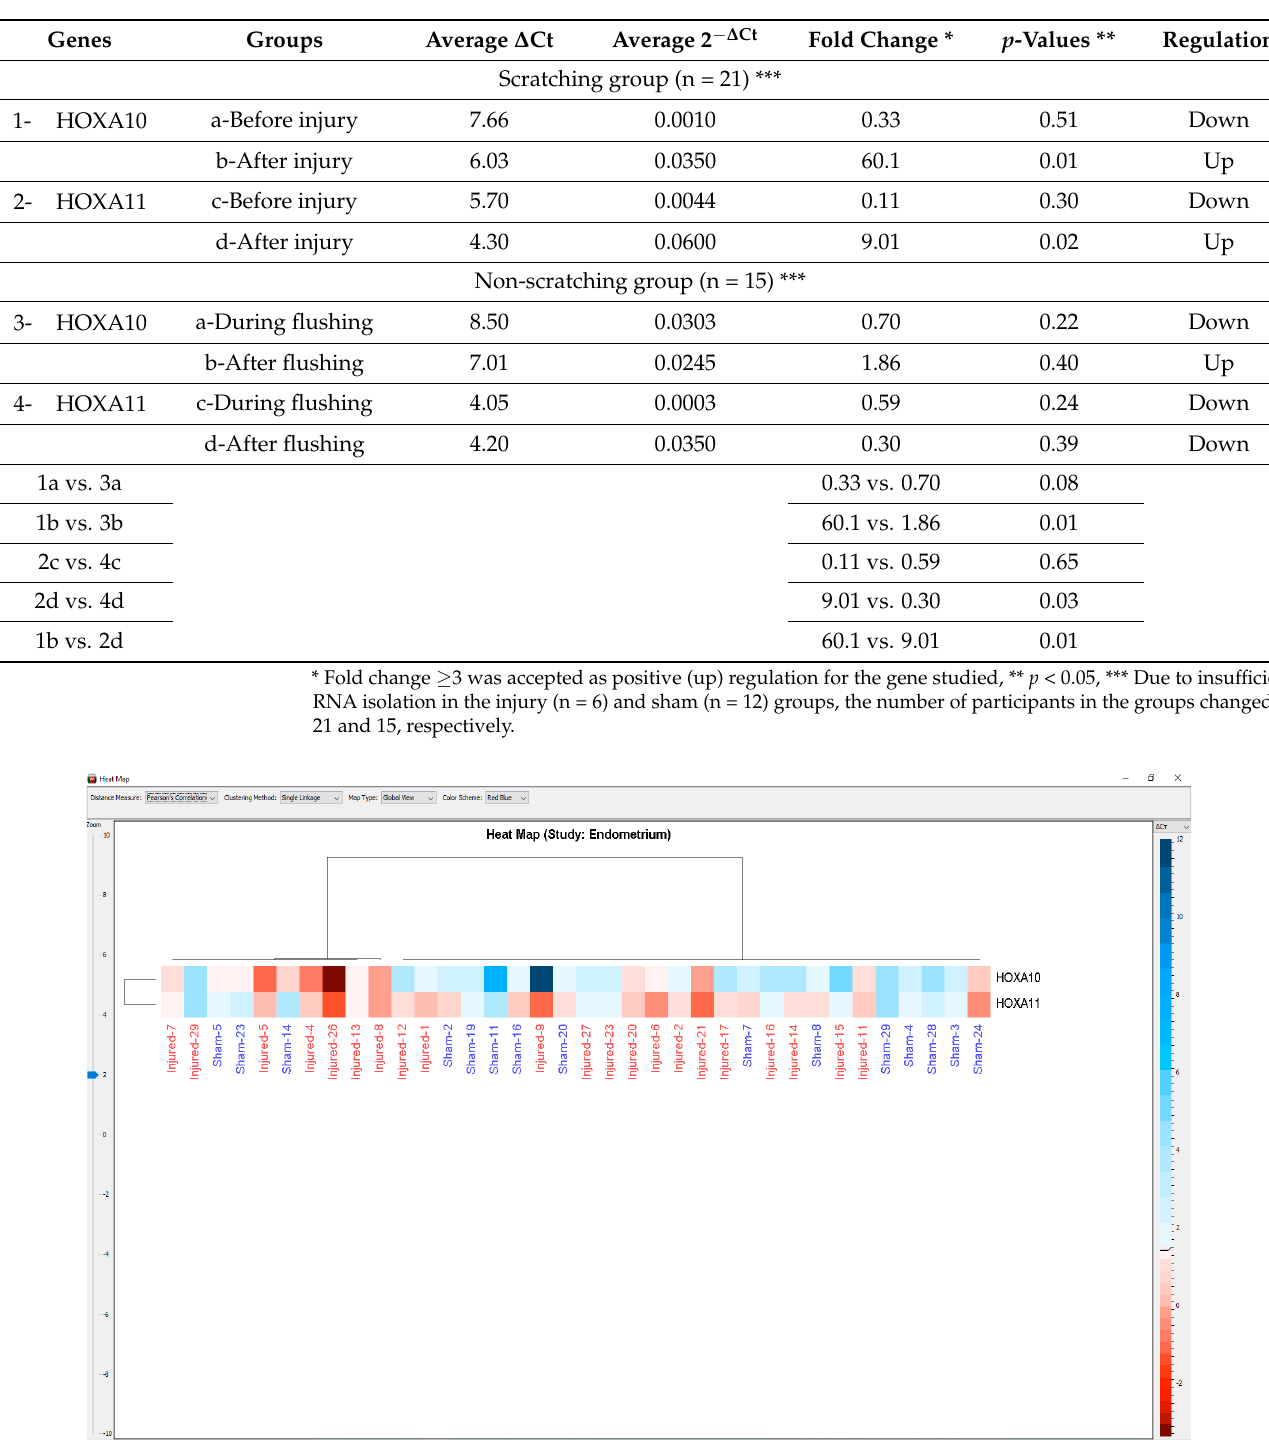
Table 2. Comparison of average ∆ Ct, 2 − ∆ Ct , and fold changes of HOXA10 and HOXA11 mRNA before and after endometrial injury.